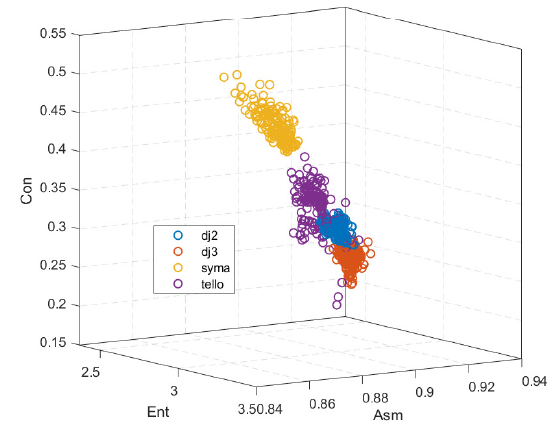
Figure 11. Texture feature distribution of different UAV micro-Doppler